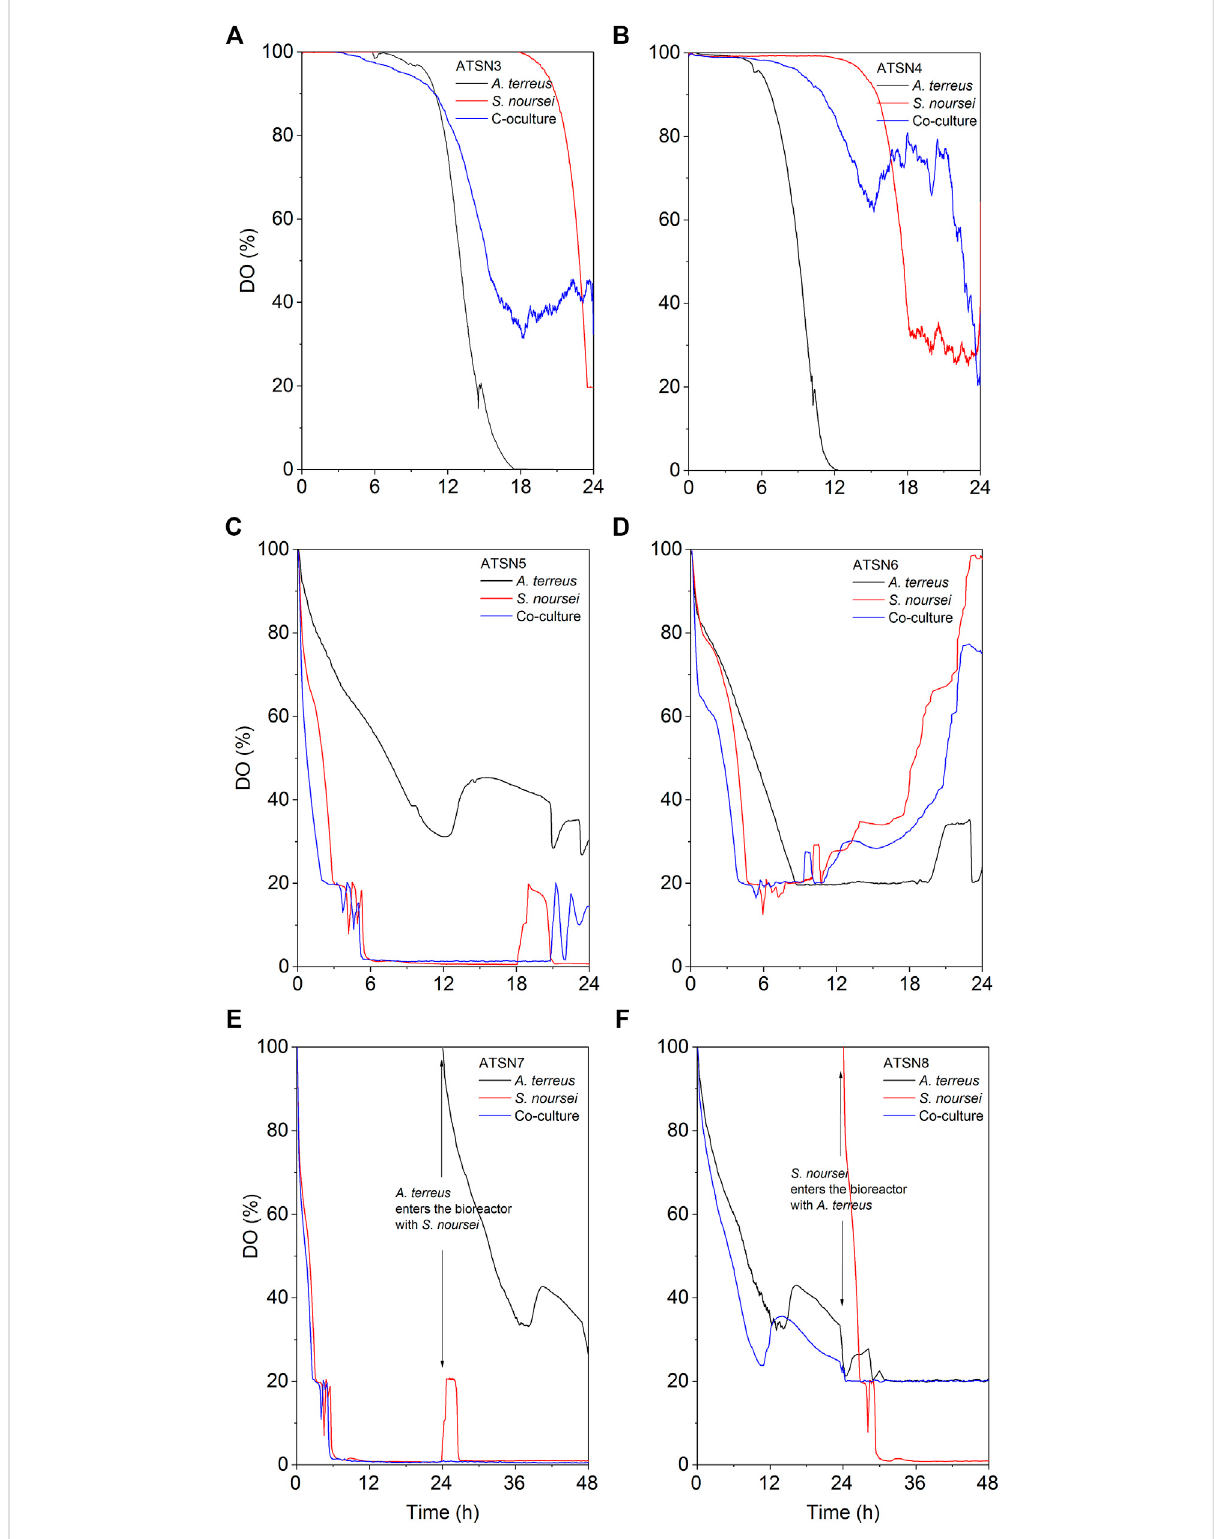
FIGURE 5 Changes of dissolved oxygen (DO) level in A. terreus and S. noursei co-cultures and the respective control monocultures in the (A) ATSN3, (B) ATSN4, (C) ATSN5, (D) ATSN6, (E) ATSN7, and (F) ATSN8 experiments during the fi rst 24 h (48 h for ATSN7 and ATSN8) of